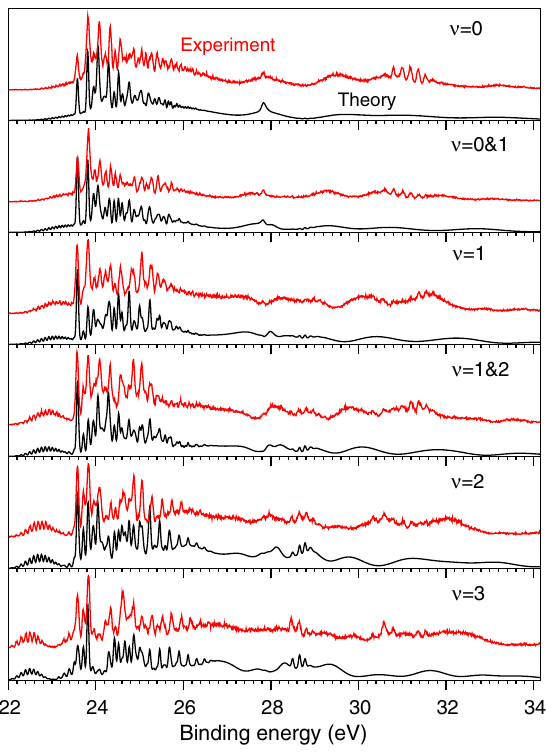
FIG. 4. Experimental (red lines) vs theoretical (black lines) RPE cross sections for several excitation energies (see Fig. 1).